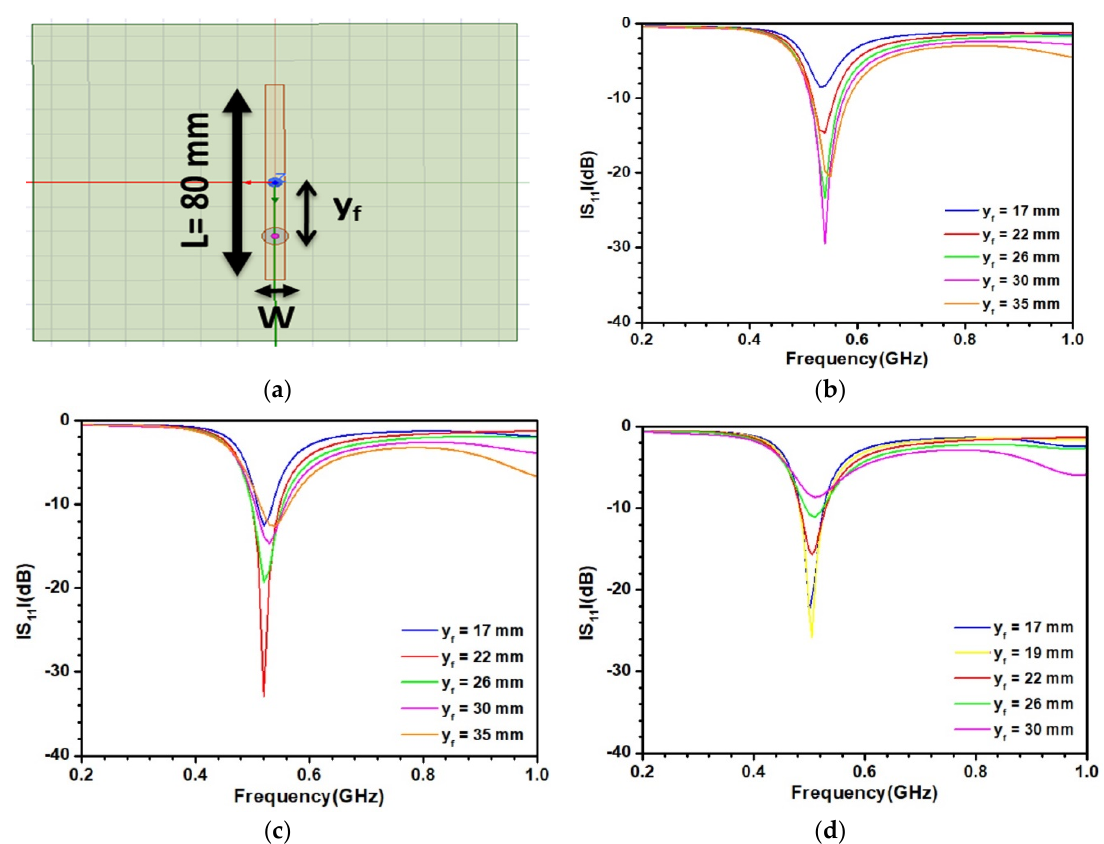
Figure 3. ( a ) Sketch of the antenna and parametric study of the antenna embedded in a material associated with ε (cid:48) = 35, tan δ = 0.1 and operating around 0.5 GHz; ( b ) W = 7 mm, ( c ) W = 5 mm, ( d ) W = 3 mm.